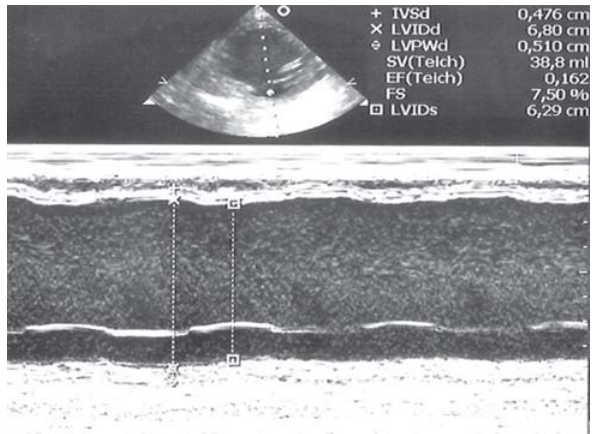
Fig. 3 – Ecocardiograma pré-operatório modo unidimensional demonstrando as medidas da cavidade ventricular esquerda (VE).